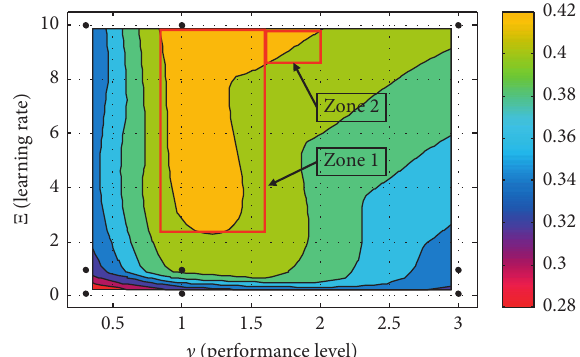
Figure 18: Maximal correlation zones vs. learning rate and per- formance level.